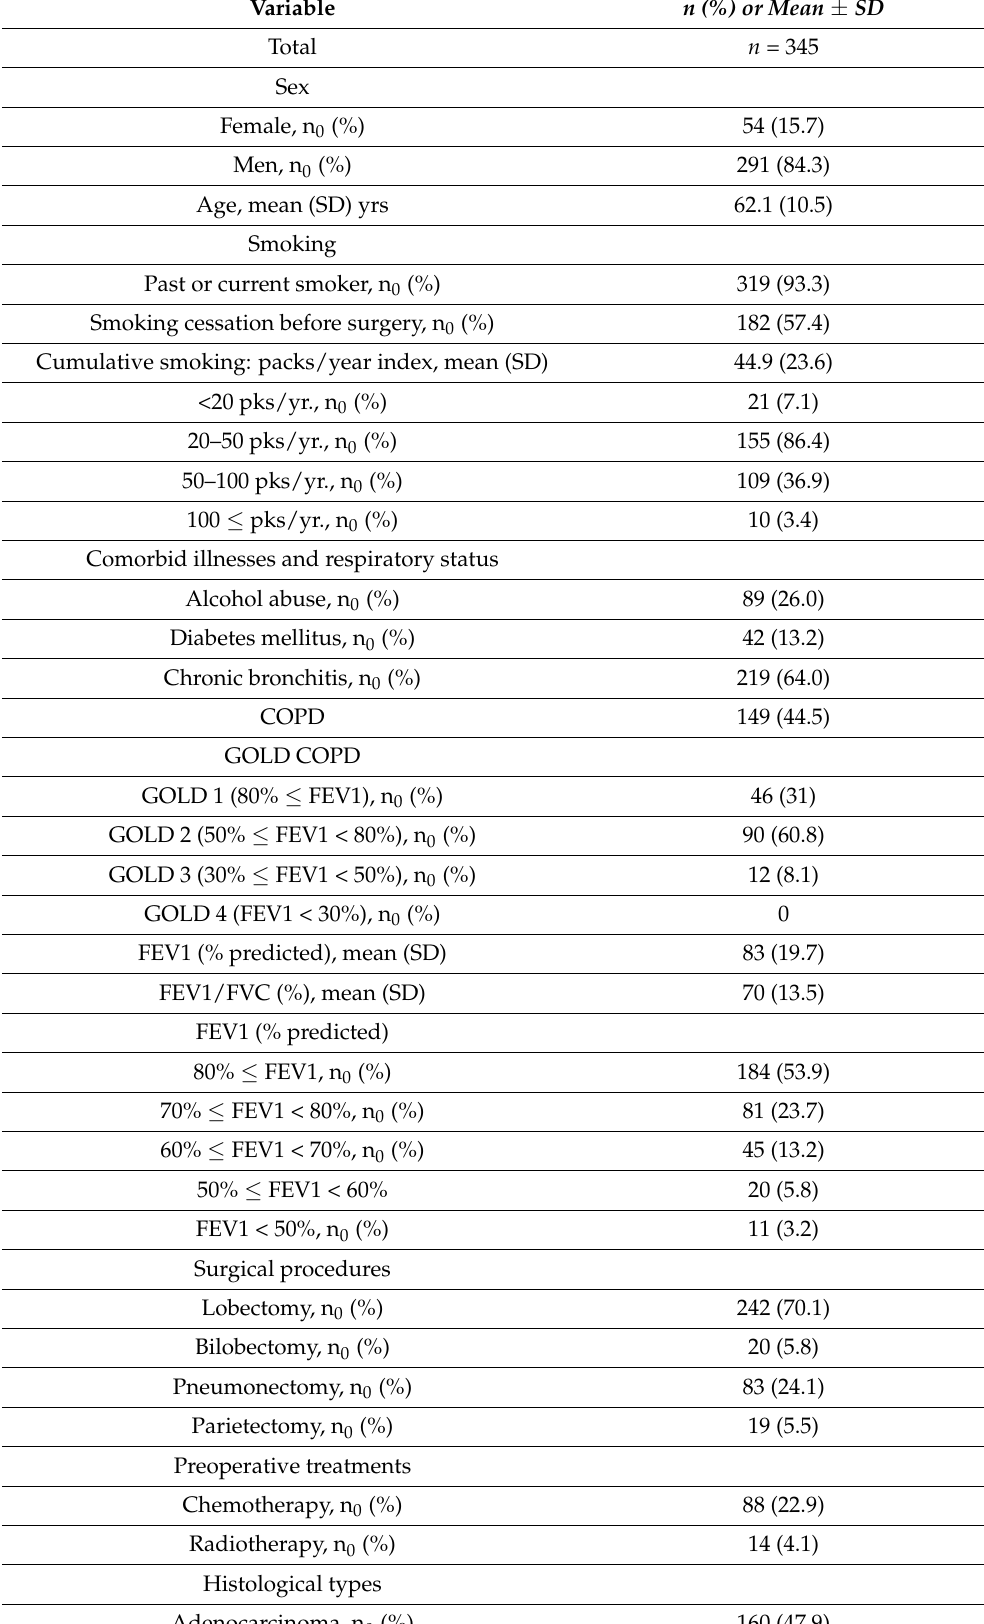
Table 1. Clinical, surgical, pathological, and biological characteristics in the cohort of 345